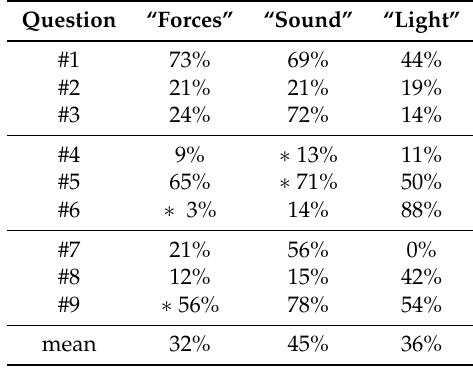
Table 6. Results from the knowledge questions shown as the percentages of correct answers (all participants, n = 113). Questions to content not addressed in the respective experiment are marked with ∗